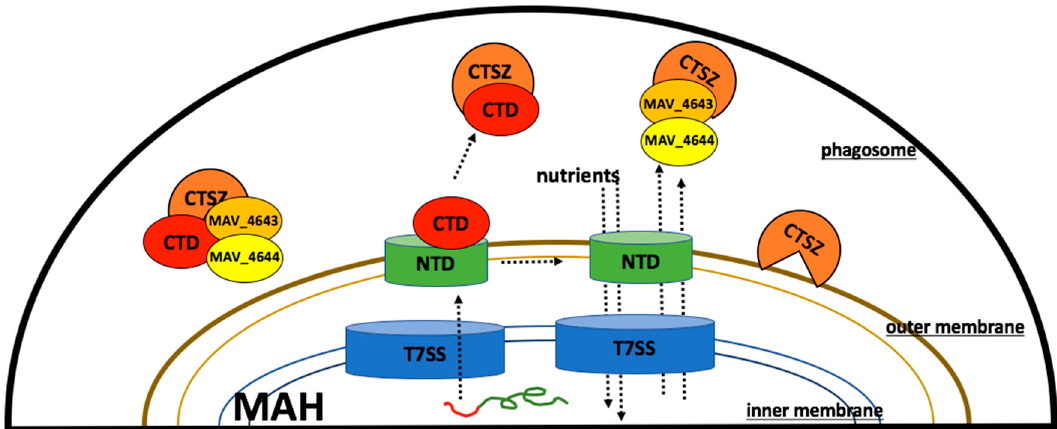
Figure 8. Hypothetical model of MAV_4644 protein interaction with cathepsin Z in the macrophage phagosome. MAV_4644 protein is transported via T7SS and assembles on the outer membrane. CTD is secreted through proteolytic cleavage, allowing CTD to interact with CTSZ, and opening NTD to transport nutrients and proteins. T7SS: type 7 secretion system, NTD: MAV_4644 protein N-terminal domain, CTD: MAV_4644 protein C-terminal domain, CTSZ: cathepsin Z